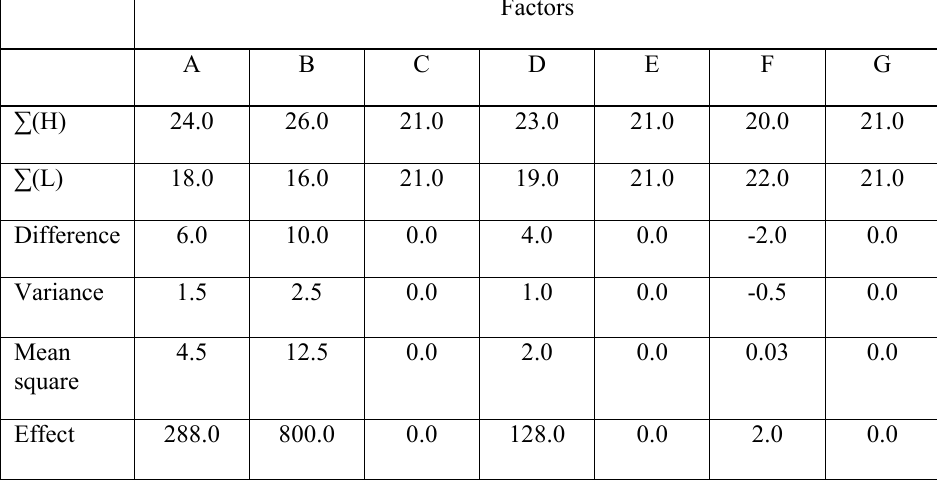
Table 2. Statistical evaluation of process parameters by Placket Burman